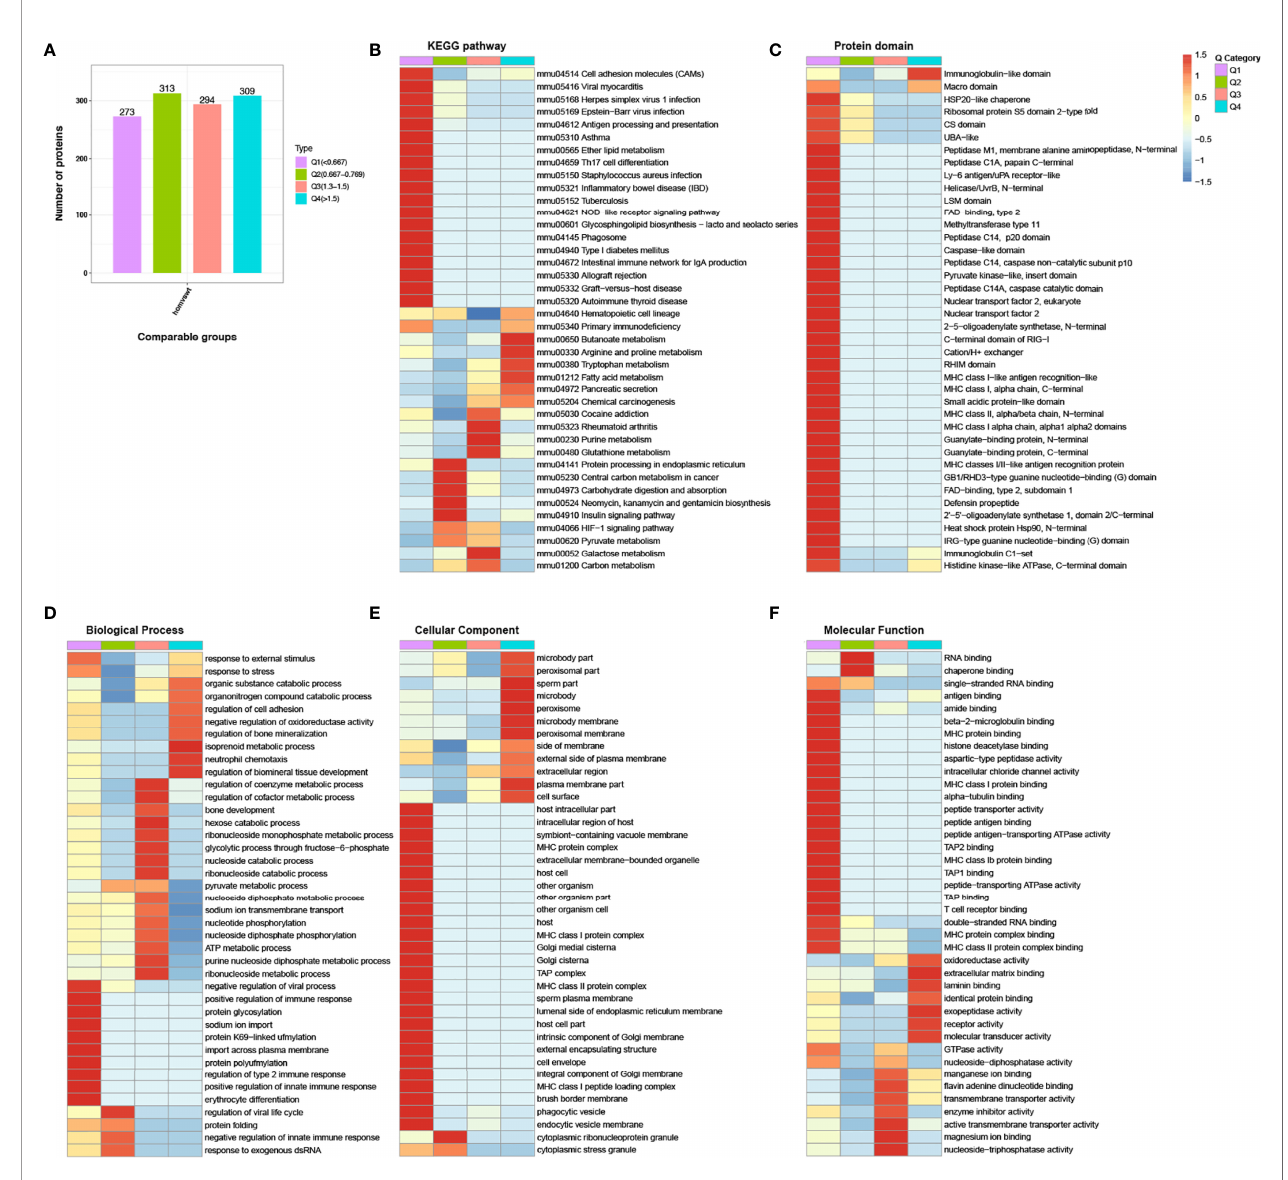
FIGURE 5 | Hierarchical cluster analysis for the differentially expressed proteins (DEPs). (A) Fold change >1.30 or <0.77 and p < 0.05 were set as the signi fi cant thresholds for the DEPs. According to the degree of fold change (FC), the DEPs were divided into four groups from Q1 to Q4. The different colors indicate the different Q categories: Q1 (FC ≤ 0.667, severely downregulated), Q2 (0.667 < FC ≤ 0.769, mildly downregulated), Q3 (1.3 < FC ≤ 1.5, mildly upregulated), and Q4 (FC>1.5, severely upregulated). (B) The distribution of Q categories in the Kyoto Encyclopedia of Genes and Genomes pathways. (C) The distribution of Q categories for the analysis of the protein domain. (D) The distribution of Q categories for the analysis of the biological process. (E) The distribution of Q categories for the analysis of the cellular component. (F) The distribution of Q categories for the analysis of the molecular function. The red color indicates stronger enrichment. The blue color indicates weaker